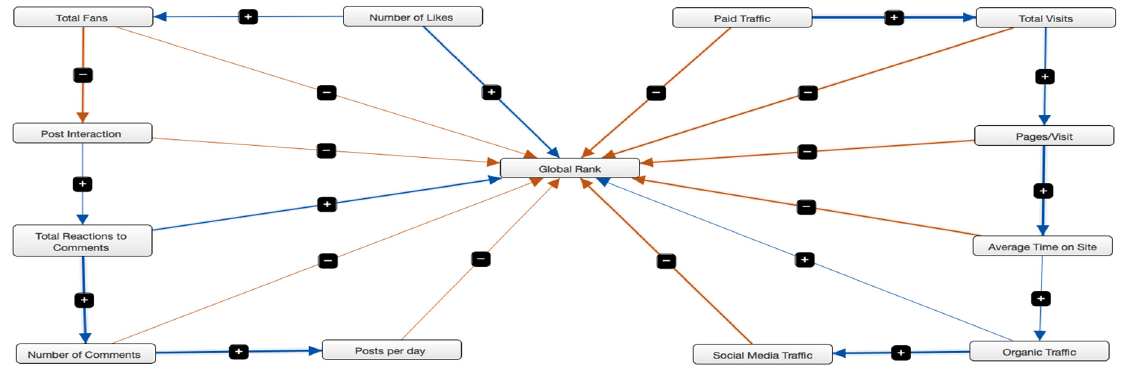
Figure 1. FCM with statistical correlations.